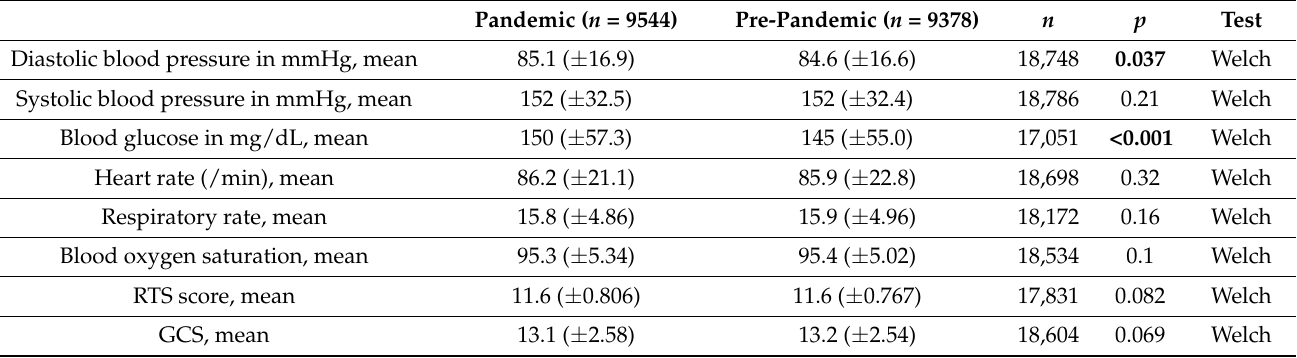
Table 2. Vital parameters and clinical